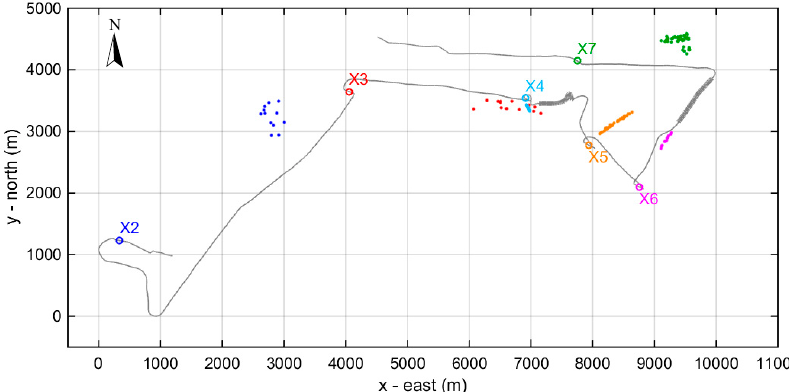
Figure 18. Combination of horizontal localization results for whale X from all stations. The vessel track (light line) is marked by thicker grey dots when the vessel is next to the whale while at surface between two deep dives (between X4 and X5 and between X6 and X7). The vessel location in the middle of each station is marked by a circle of different color—the same color is used for the corresponding localization results of the sperm whale (color dots).